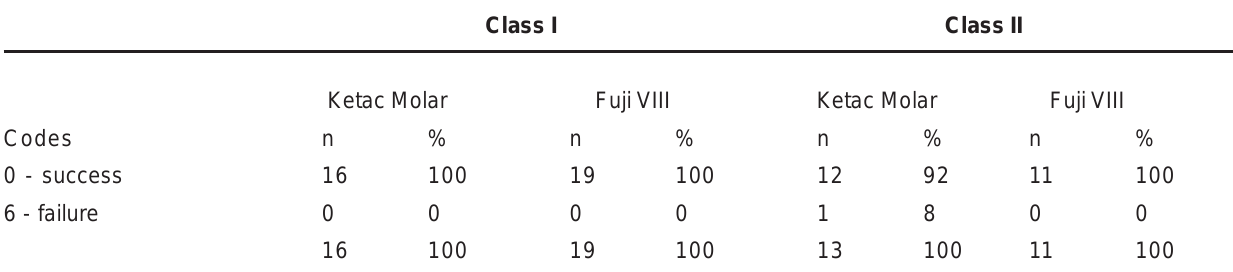
TABLE 3- Status of the ART restorations after 6